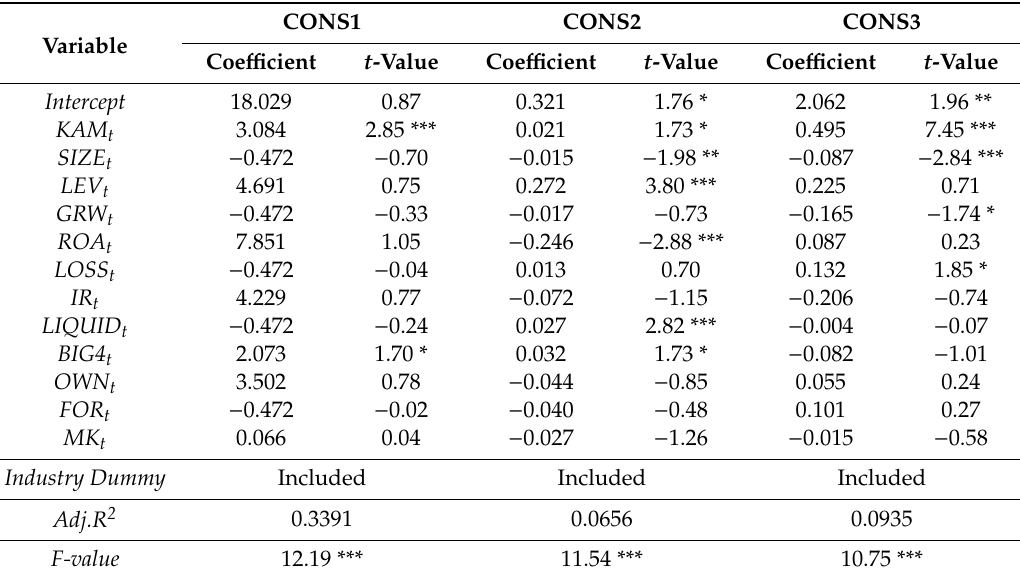
Table 5. The E ff ects of KAM on Conservatism ( n =